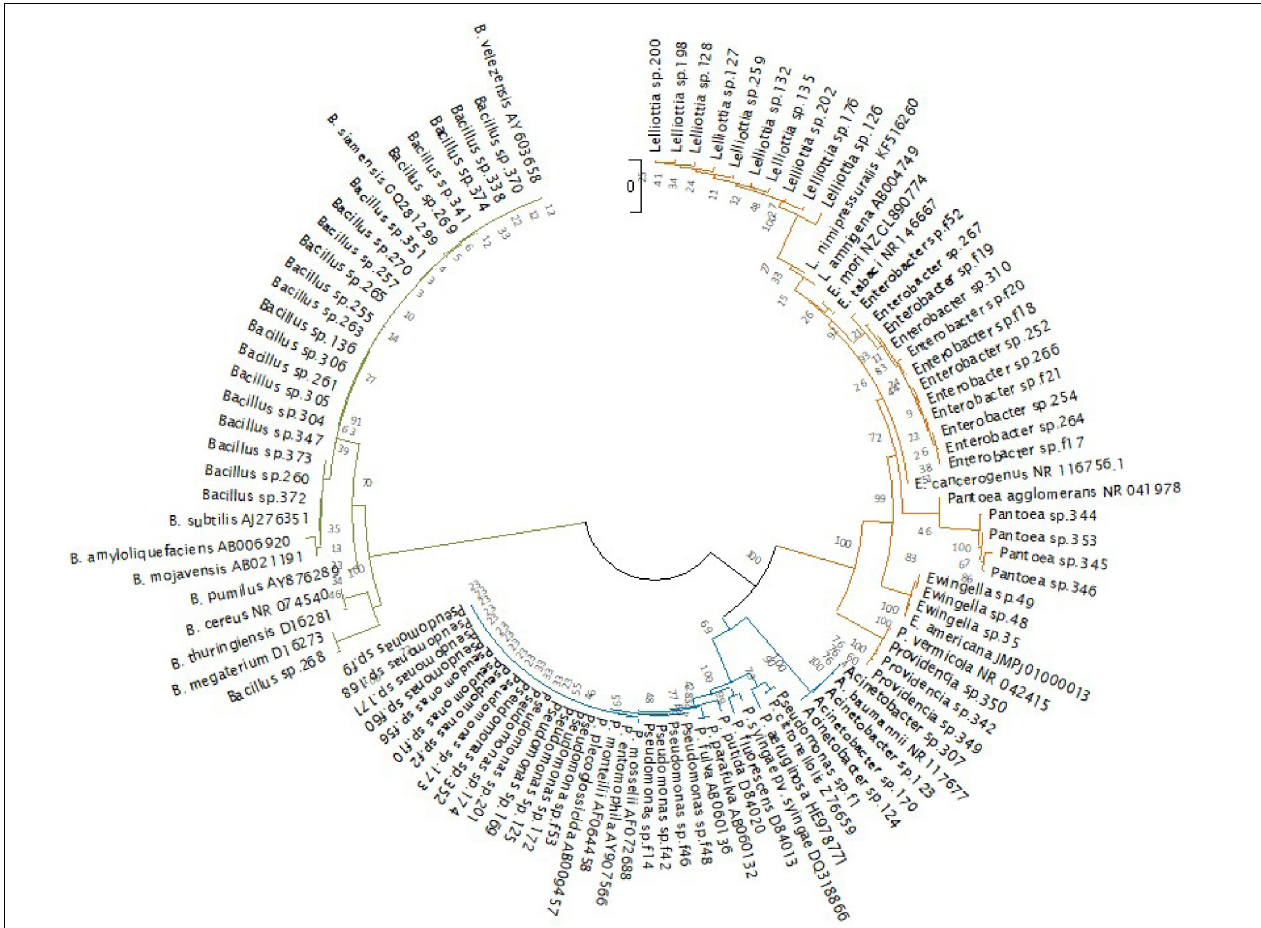
FIGURE 6 | Phylogenetic tree of the 77 endophytic strains isolated in this study and 29 bacterial type strains. ( Bacillales in green, Pseudomonadales in blue, and Enterobacteriales in orange). The evolutionary history was inferred using the neighbor-joining method (Saitou and Nei, 1987). The evolutionary distances were computed using the Kimura 2-parameter method (Kimura, 1980). There were a total of 824 positions in the final dataset. Evolutionary analyses were conducted in MEGA X (Kumar et al.,